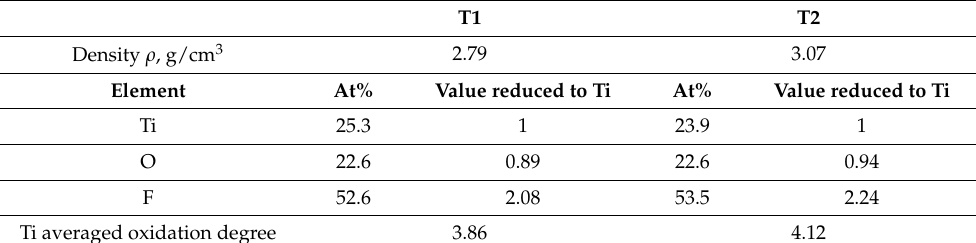
Table 7. Pycnometric density, the elemental composition of materials, and average oxidation degree of Ti in the studied materials T1 and